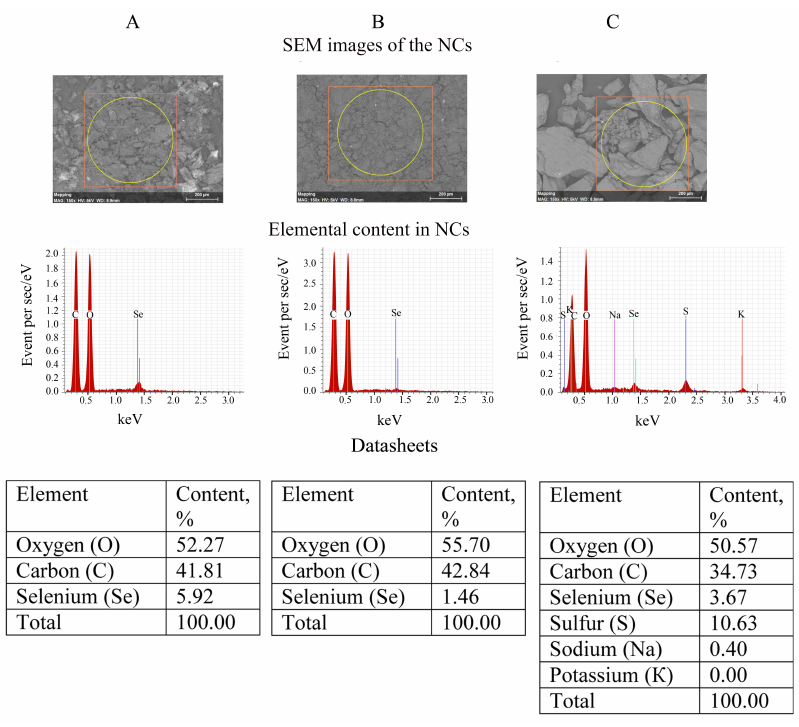
Figure 5. Results of energy-dispersive X-ray spectroscopy microanalysis (EDXMA) of Se/AG ( A ), Se/ST ( B ), and Se/CAR ( C ) NCs.